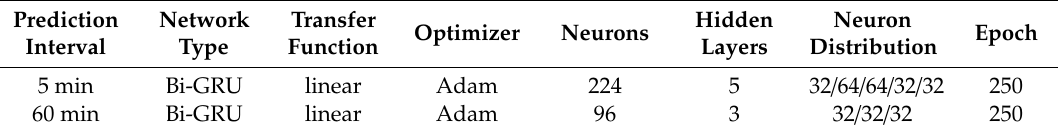
Table 4. Deep RNN model architectural configurations for the two-time intervals.